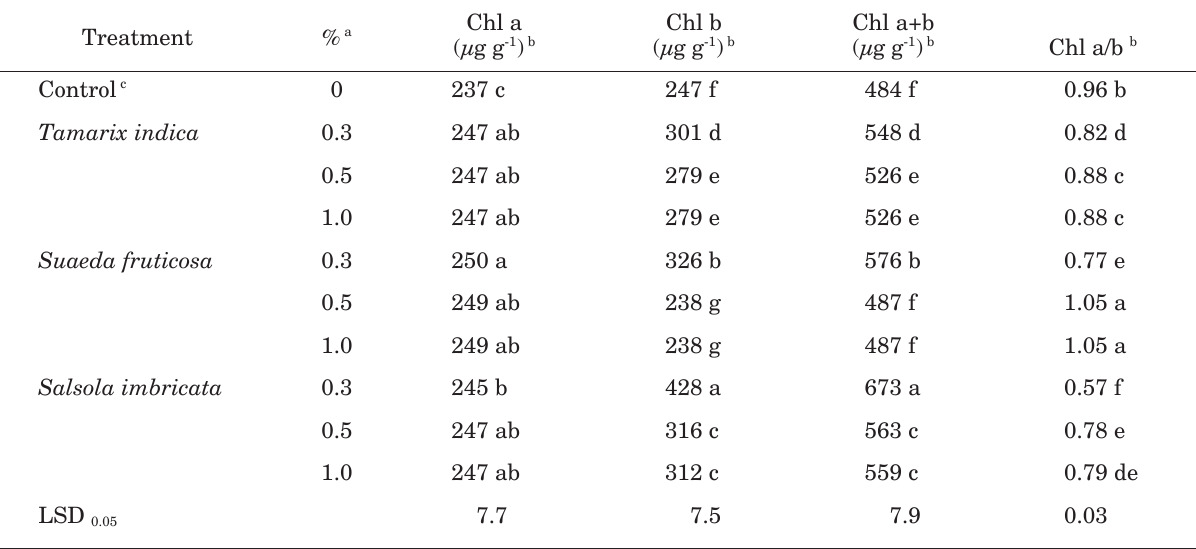
Table 5. Effect of three halophytes on the chlorophyll contents of okra infected with Meloidogyne javanica .